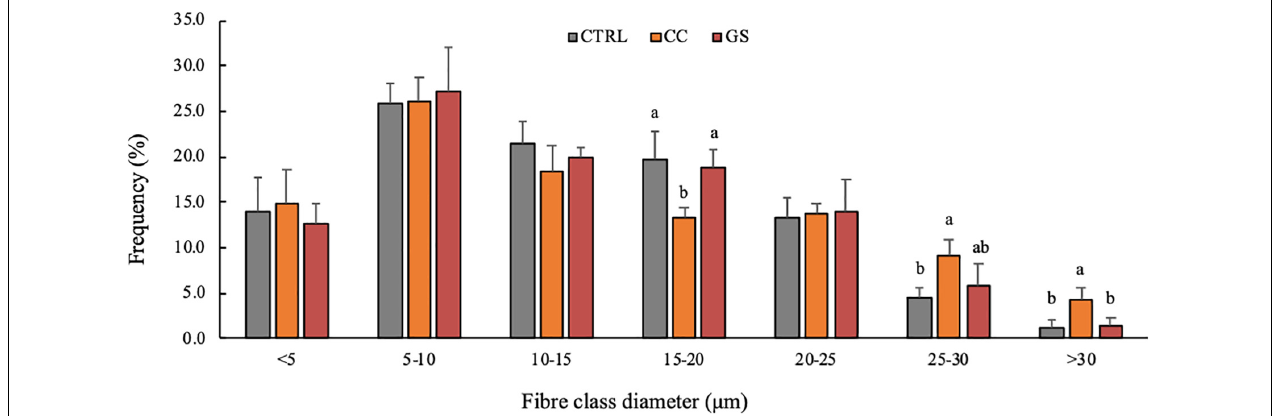
FIGURE 1 | Frequency of fibers per class diameter in Senegalese sole, at 70 DAH. Values are presented means ± SD ( n = 5). Different superscript letters indicate significant differences ( P < 0.05, one-way ANOVA) between the dietary treatments (CTRL, CC and GS).